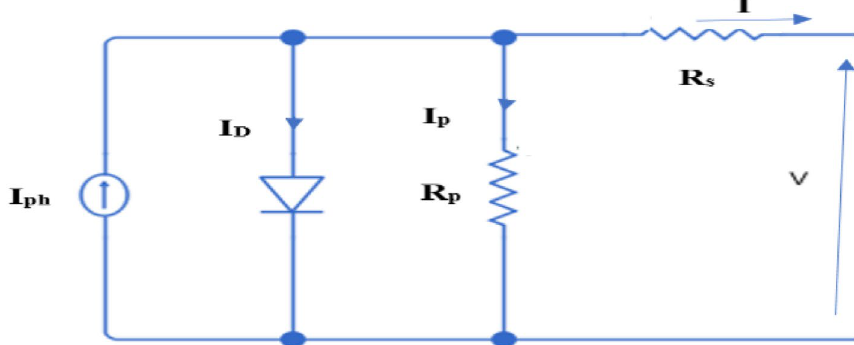
Fig. 3 Equivalent circuit of a PV module. I ph , photon current source. I D , diode current. R p , parallel leakage resistance. R s , series contact